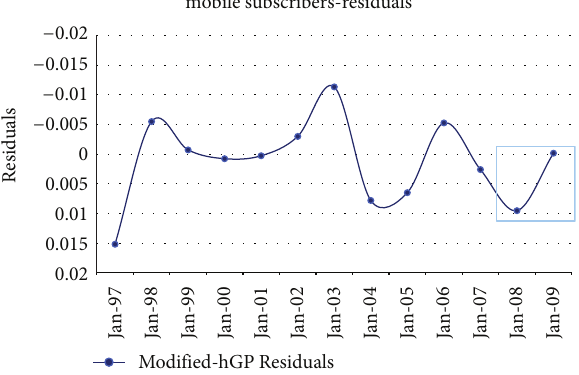
Figure 21: Residuals of the modified-hGP model in forecasting (2 years window period) of the total number of OECD